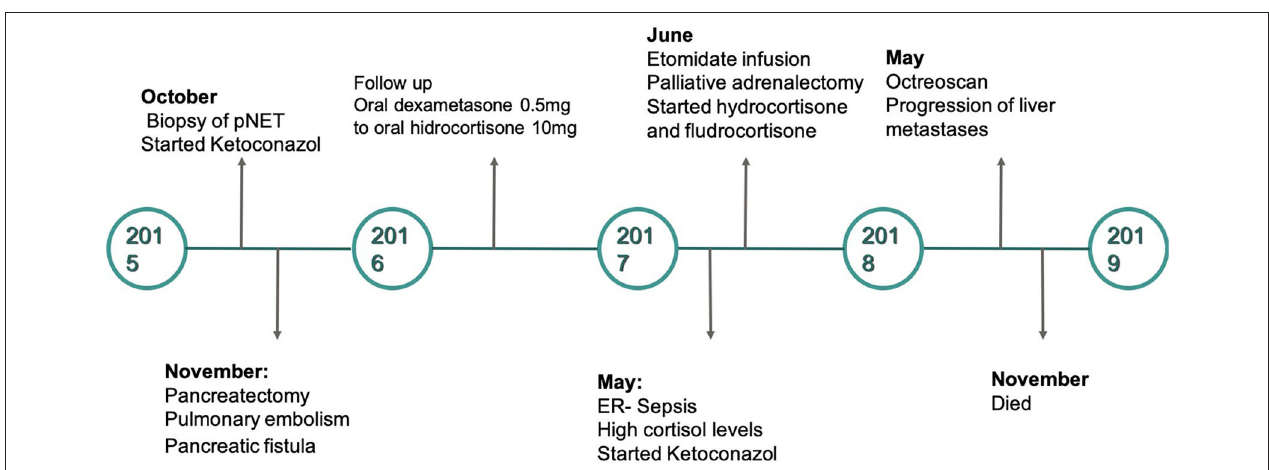
FIGURE 3 | Timeline of the case